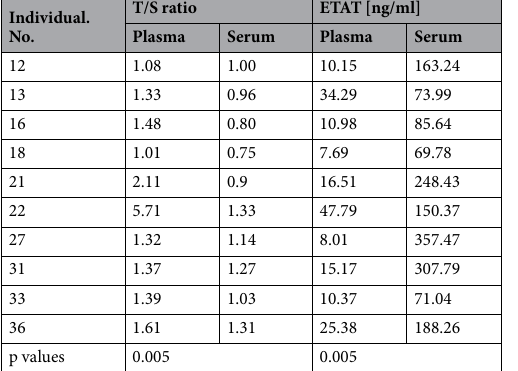
Table 1. Selected characteristics of samples used for stimulatory experiments. Wilcoxon signed-rank test was